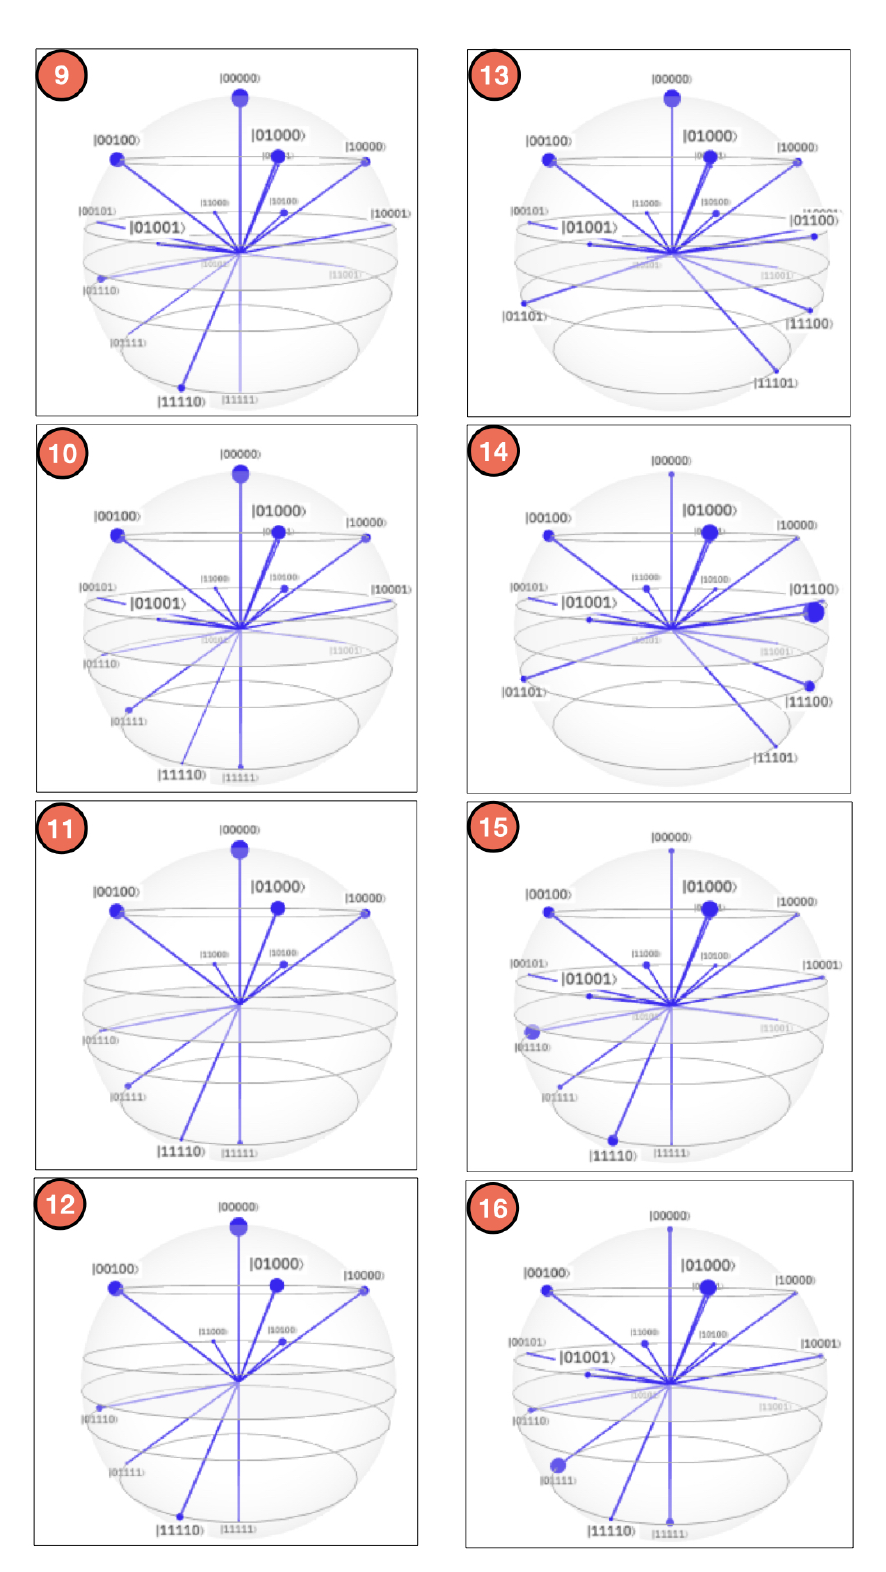
Figure A2. QSOD Bloch sphere measurements steps